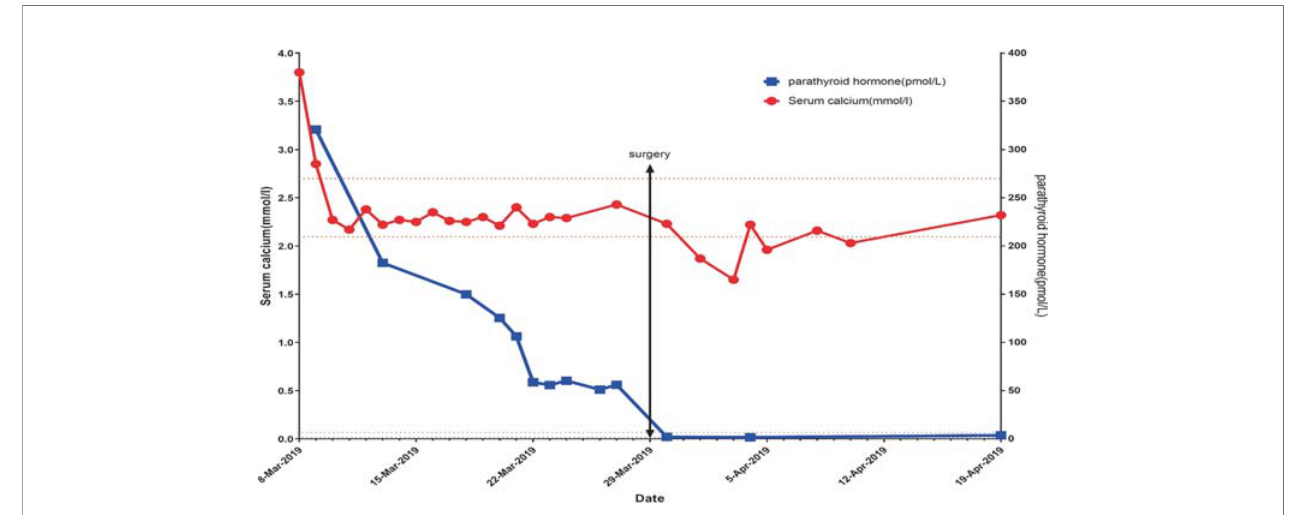
FIGURE 2 | After admission, the blood calcium level was 3.6 mmol/L. After 2000-4000 ml of NS for 5 days and salmon calcitonin (300 IU ivgtt), the blood calcium level gradually decreased and remained within the normal range. After surgery, the blood calcium level decreased, reaching the lowest level (1.65 mmol/L). After that, the calcium level was gradually restored to normal. There was a progressive decrease in the PTH level; however, the PTH level was stabilized at 50-60 pmol/L at 12 days post-admission, and this situation persisted for 1 week. One day post-operatively the PTH level rapidly decreased to 1.95 pmol/L, followed by a slow, gradual